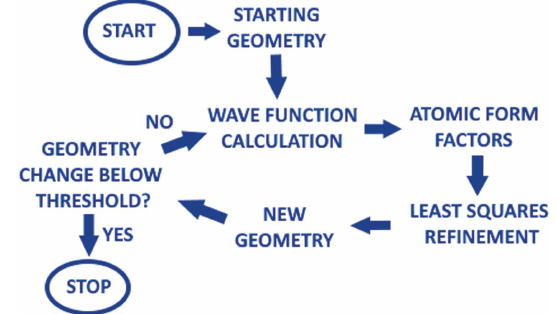
Figure 1 Scheme of the HAR